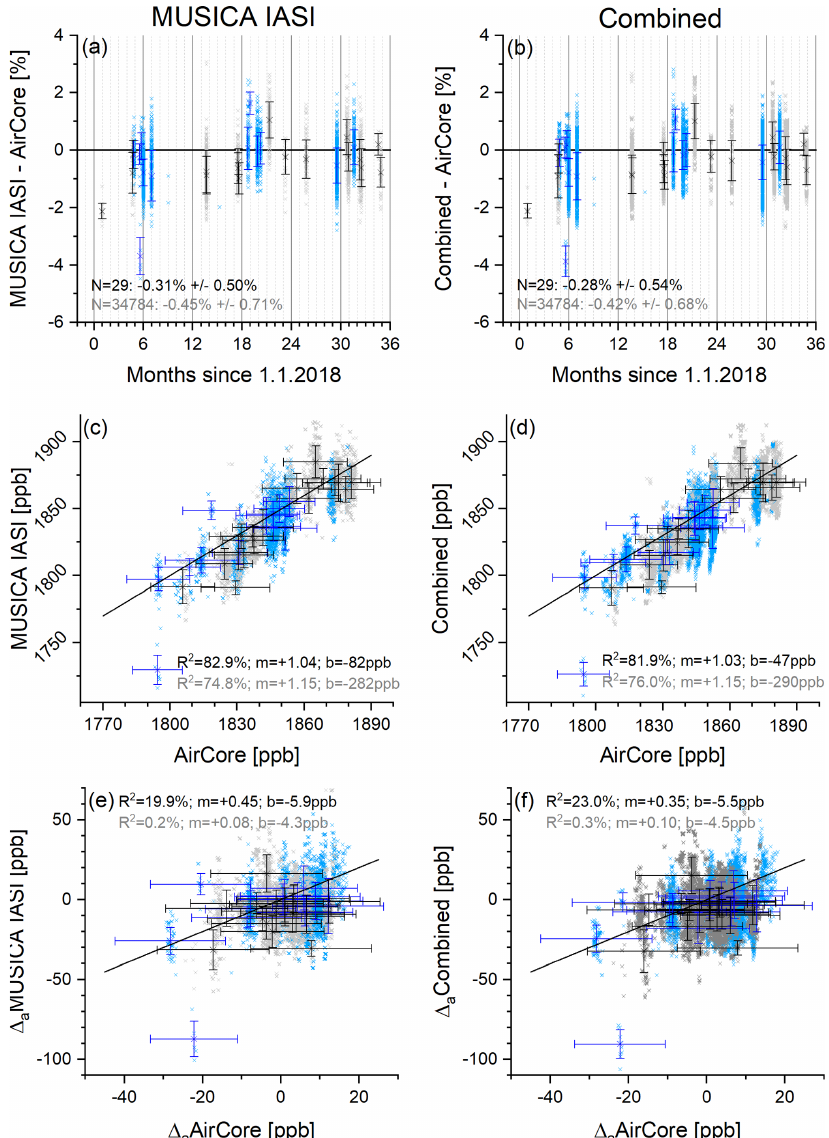
Figure 12. Same as Fig. 11 but for comparisons of UTLS partial-column-averaged CH 4